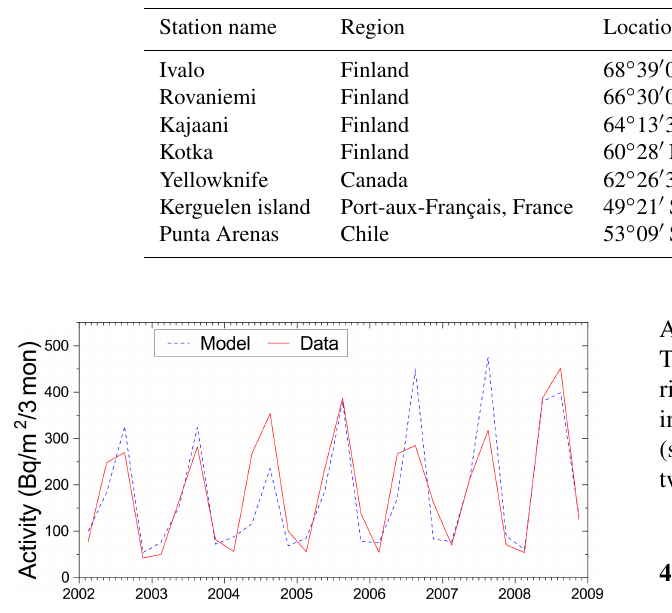
Figure 2. Quarterly total deposition of 7 Be at northern Finland sta- tions (Ivalo and Rovaniemi) for the period 2002–2008. The blue dashed line represents the total modeled deposition, while the red line depicts the measured